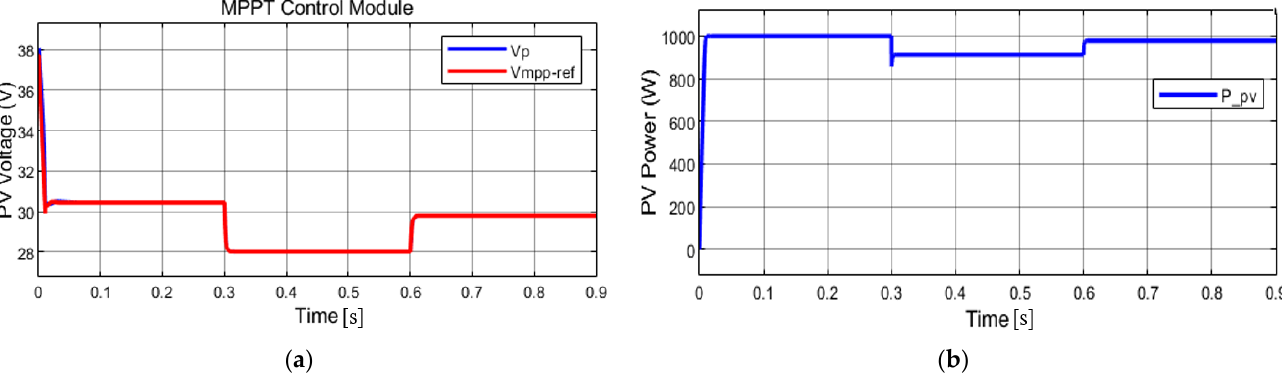
Figure 16. MPPT module performance in case with the backstepping approach for constant solar irradiation: ( a ) PV voltage; ( b ) PV output power.